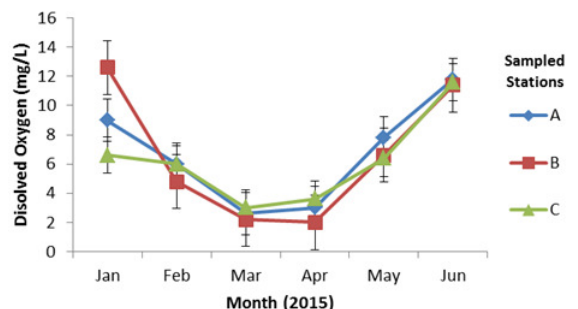
Fig. 8. The monthly mean variation in the dissolved oxygen (mg/L) level of the water sampled from Saba